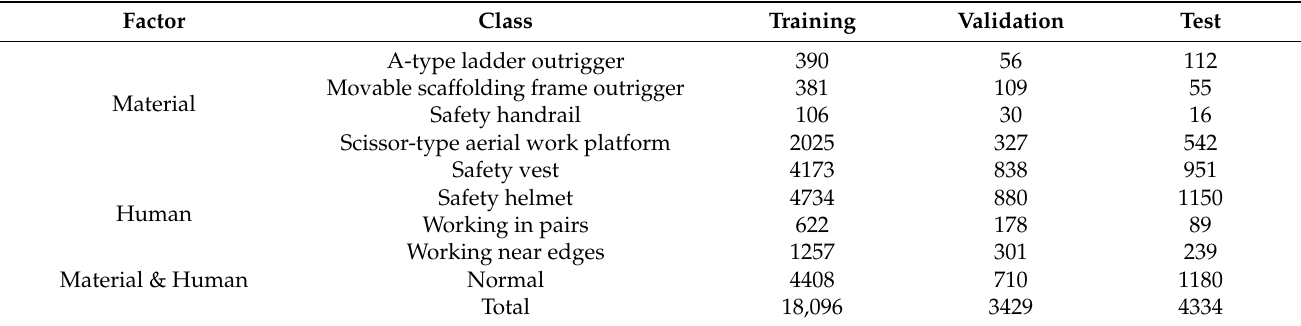
Table 1. Data distribution by